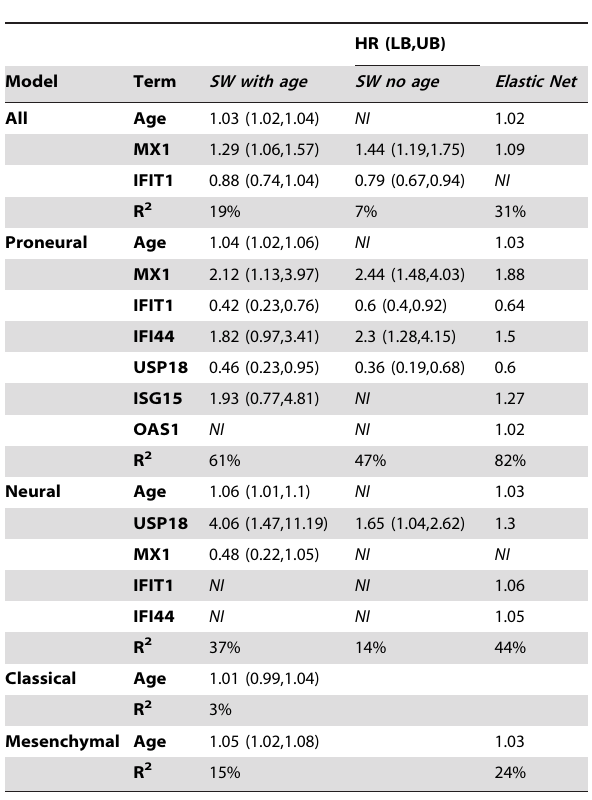
Table 2. Multi-gene Cox Proportional Hazards models for all samples and specific subtypes using three different model selection methods: Stepwise regression with age as a covariate (SW with age), stepwise regression without age (SW no age), and Elastic Net.